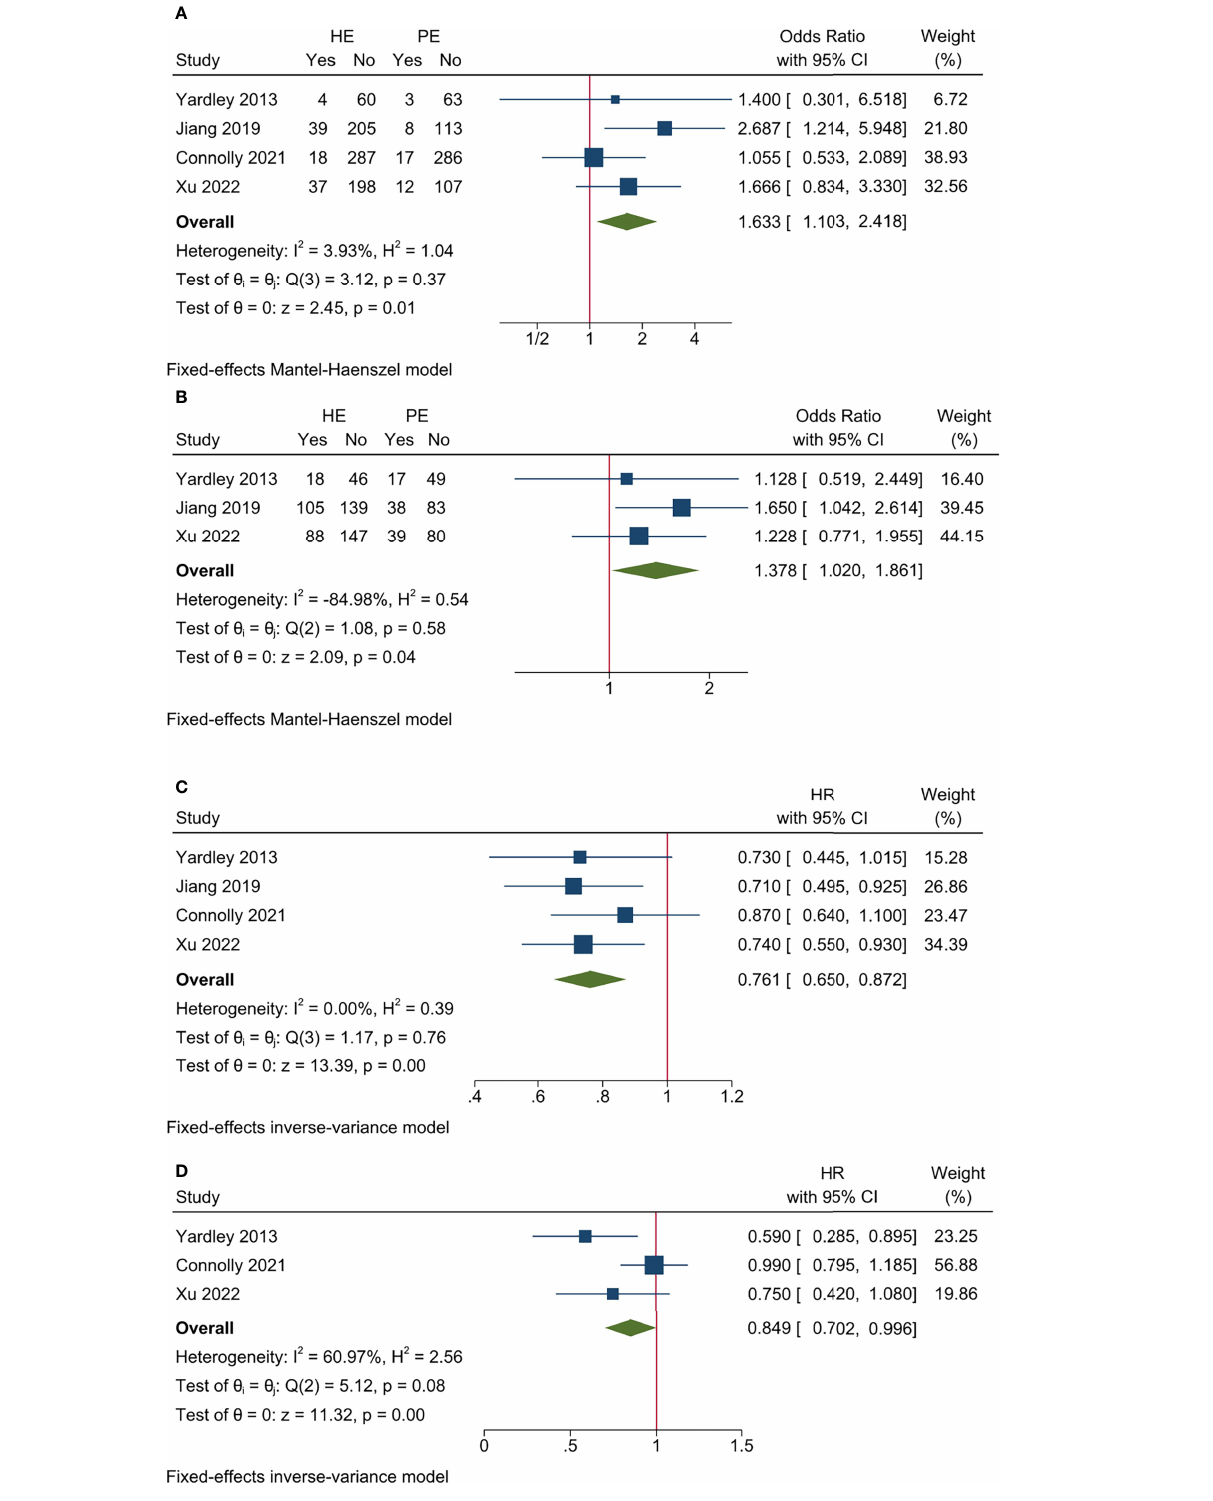
FIGURE 2 | Pooled results for ef fi cacy endpoints of included studies. (A) ORR; (B) CBR; (C) PFS; (D)